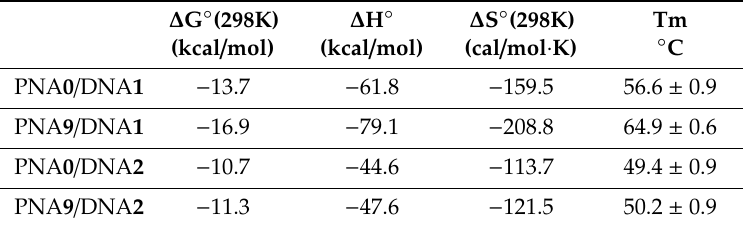
Table 3. Thermodynamic parameters of the PNA / DNA duplex.